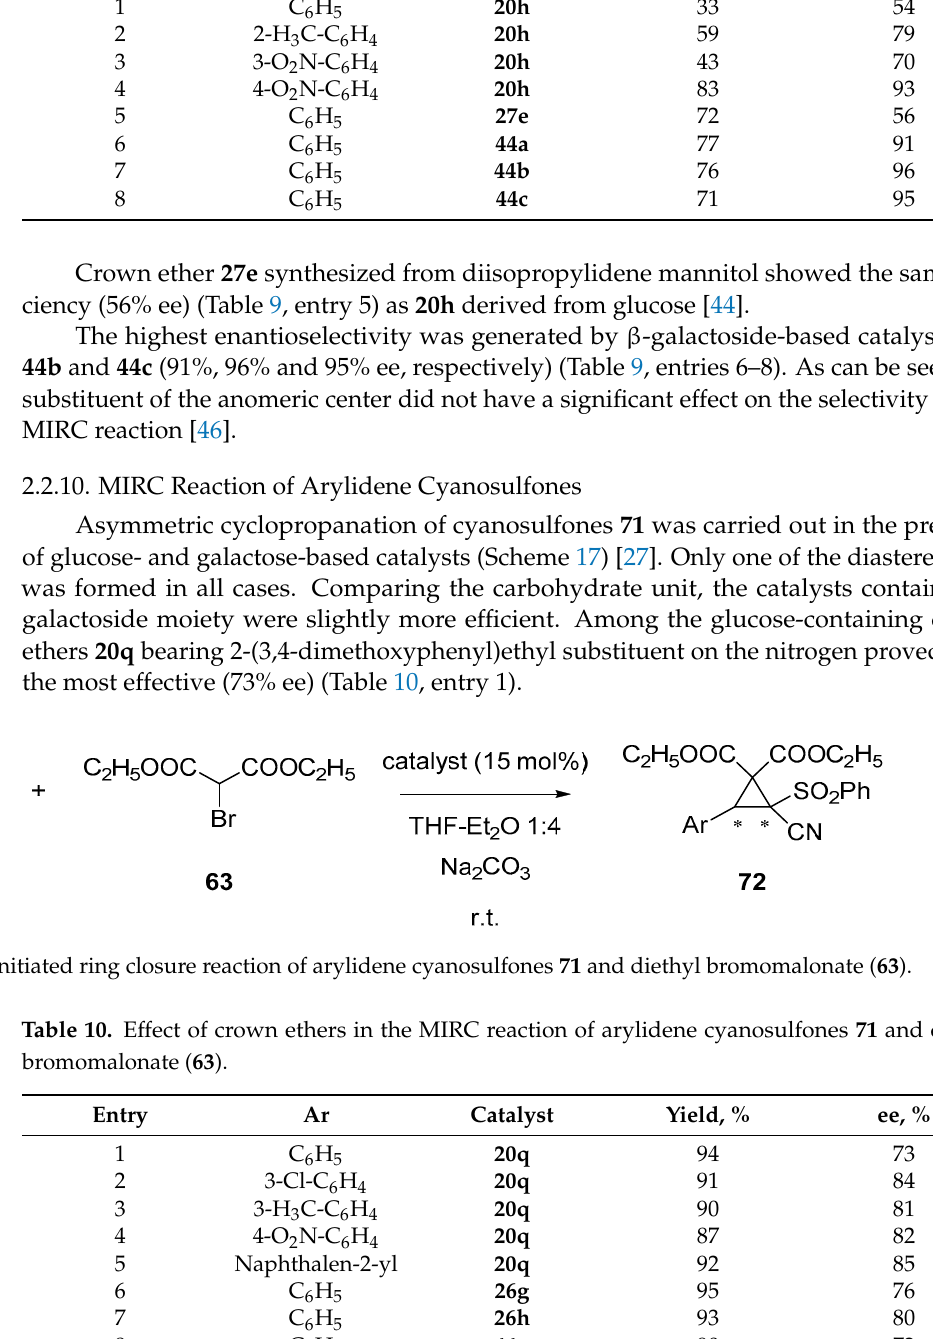
Table 9. Effect of crown ethers in the MIRC reaction of arylidene indane-1,3-diones ( 69 ) and di- ethyl bromomalonate ( 63 ).